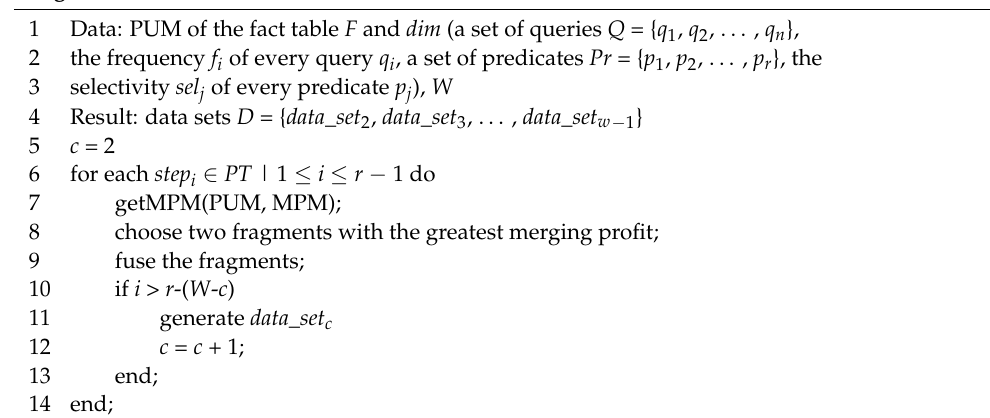
Algorithm 1. Generate data sets.